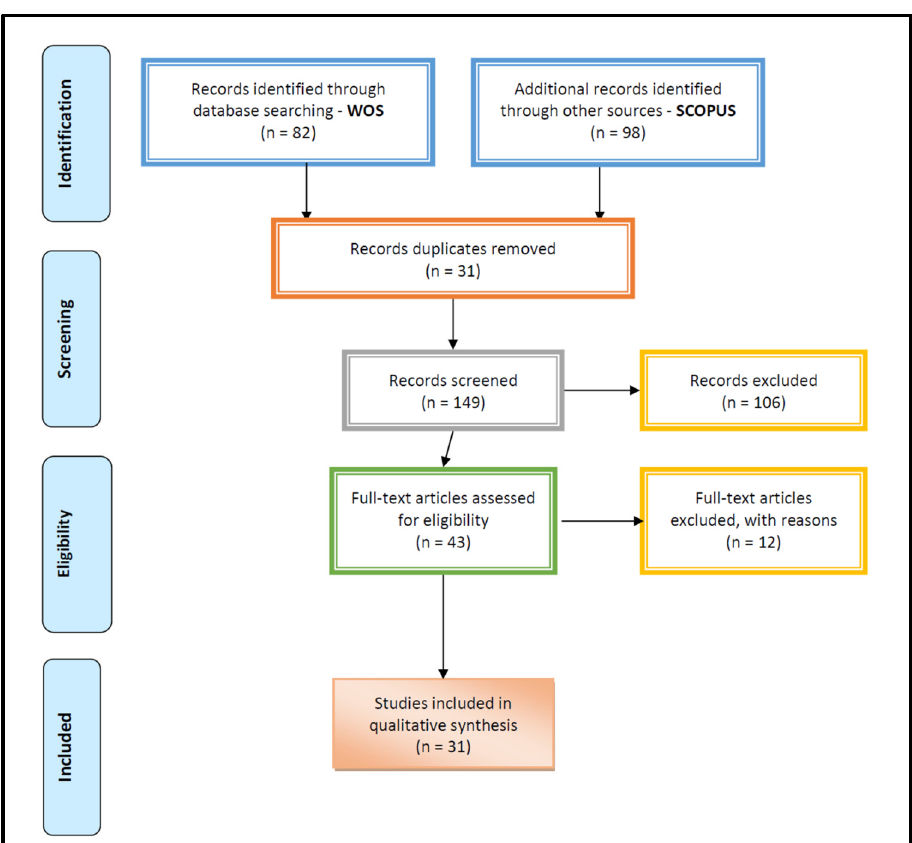
Figure 2. PRISMA Diagram (Liberati et al. 2009).